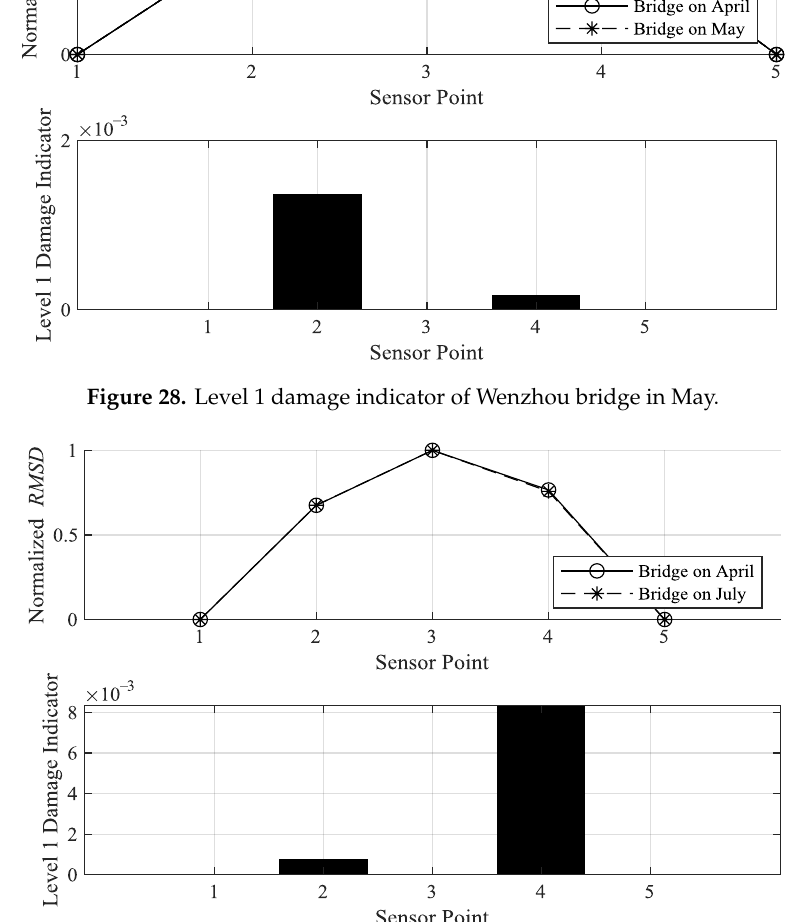
Figure 29. Level 1 damage Indicator of Wenzhou Bridge in July.